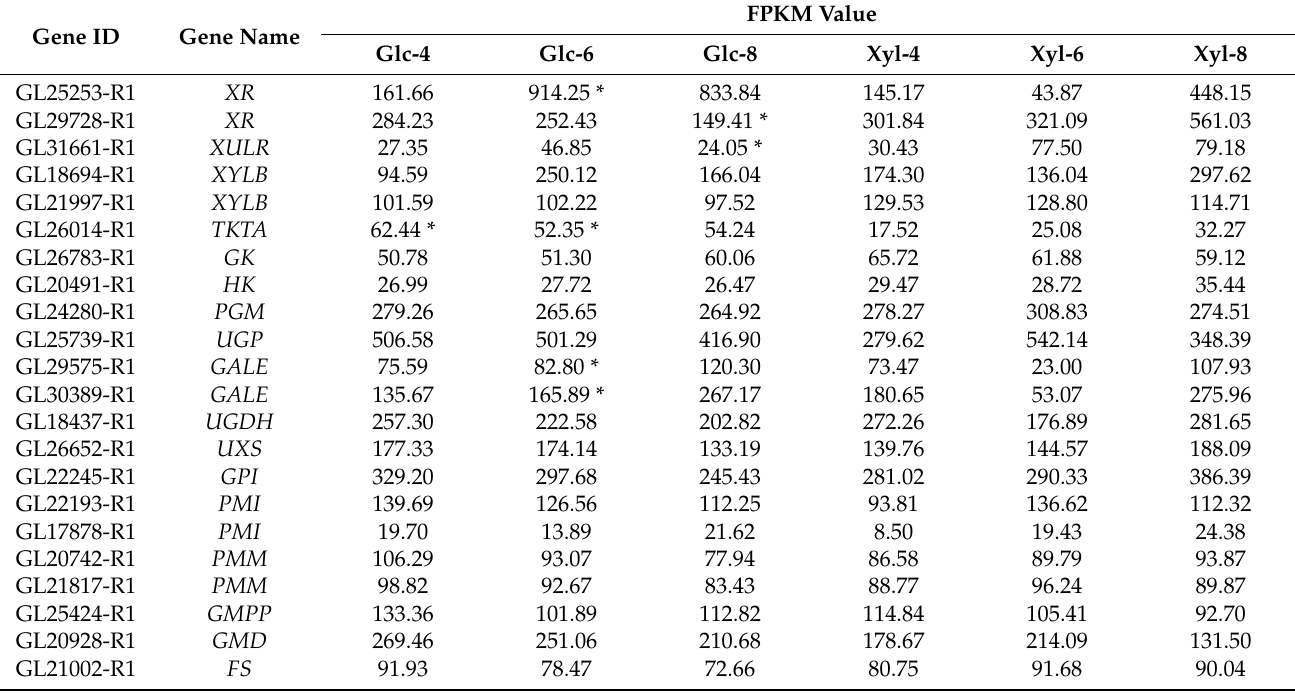
Table 1. FPKM value of all the genes involved in the nucleotide sugar biosynthetic pathway in Ganoderma lucidum during